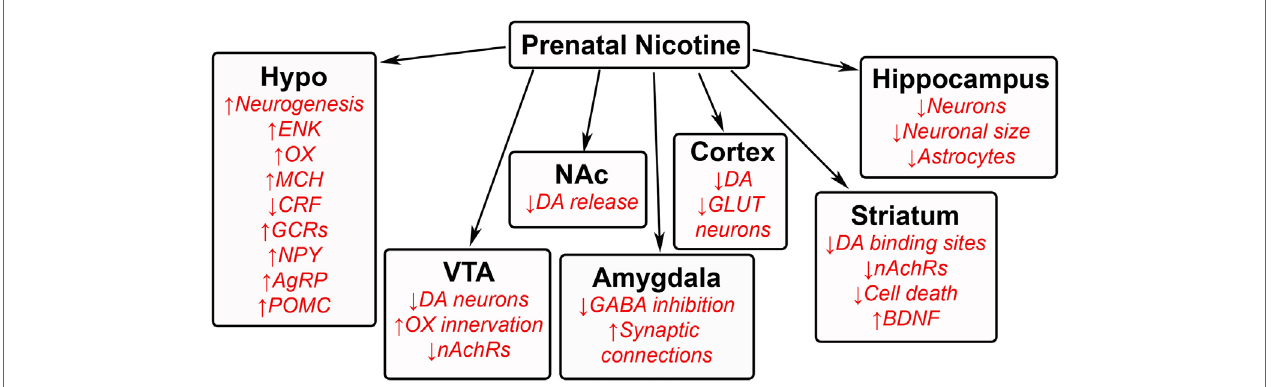
FiGURe 5 | effects of prenatal nicotine exposure on offspring brain . A schematic summarizing some of the changes that occur in the brains of offspring after being exposed to nicotine during gestation. GAL, galanin; ENK, enkephalin; OX, orexin; MCH, melanin-concentrating hormone; CRF, corticotrophin releasing factor; GCRs, glucocorticoid receptors; NPY, neuropeptide Y; AgRP, agouti-related protein; POMC, proopiomelanocortin; DA, dopamine; nAchRs, nicotinic acetylcholine receptors; GABA, γ -aminobutyric acid; GLUT, glutamate; BDNF, brain-derived neurotrophic